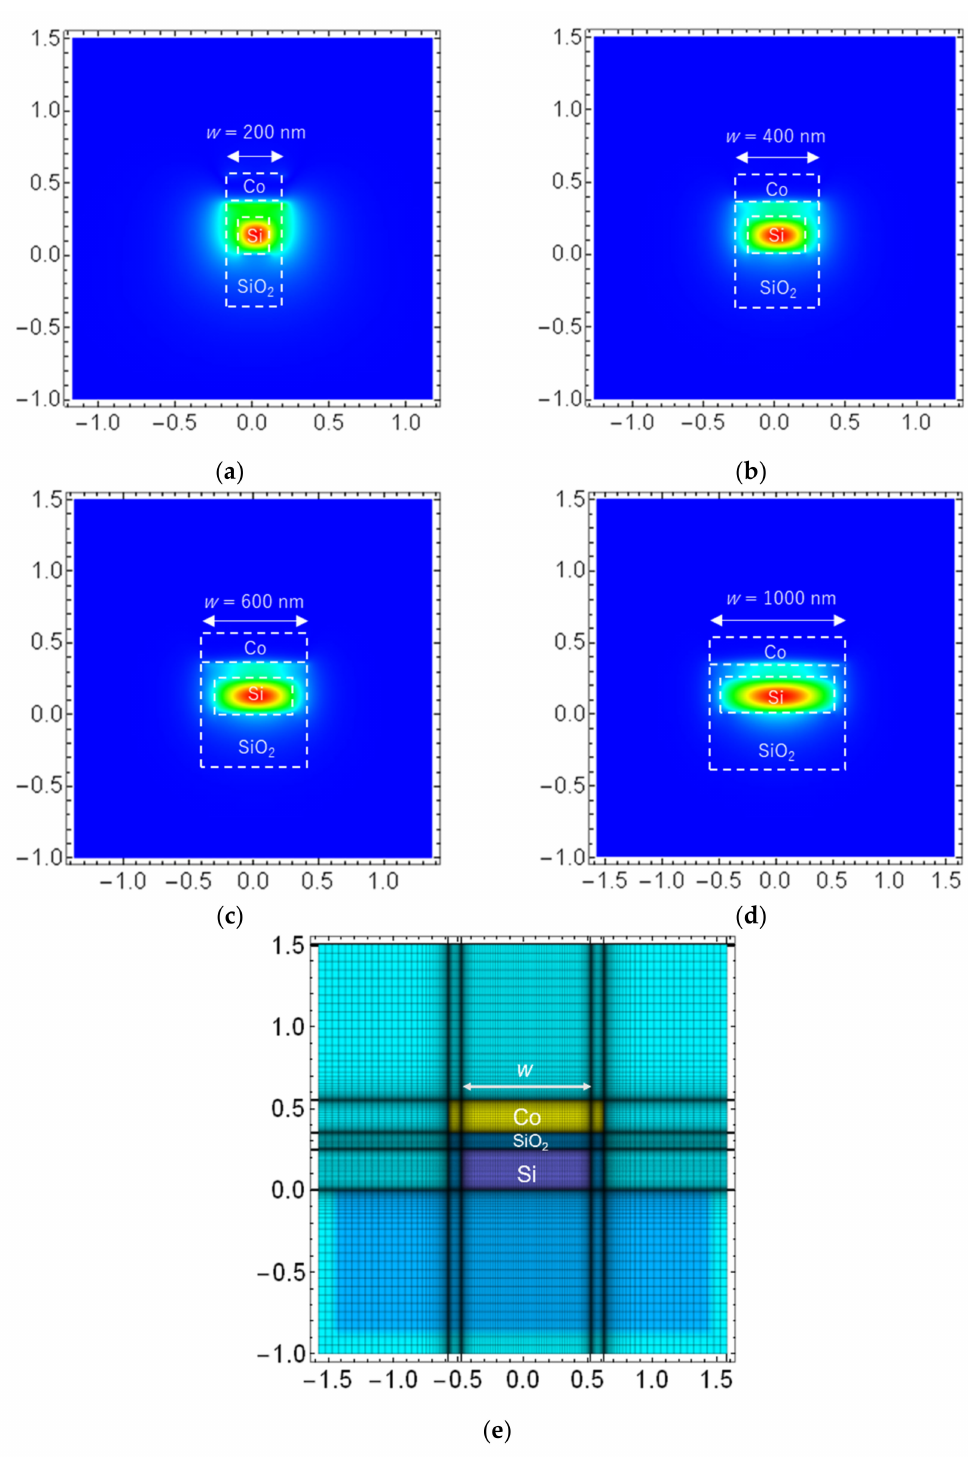
(cid:12) (cid:12) Figure 8. Calculated profile of the horizontal component of the magnetic field (absolute value (cid:12) ) for TM-like mode light (cid:12) H y with the Si waveguides for waveguide width ( a ) w = 200 nm, ( b ) 400 nm, ( c ) 600 nm, and ( d ) 1000 nm. ( e ) Definition of the mesh for calculation of the mode profile. The interfaces between the Co, SiO 2 , and Si layers are shown by white dotted lines. Estimated temperature rise of 331 K with ∆ R max = 0.048 Ω for w = 400 nm was determined with sampling time interval (1 s) of the digital multimeter used in this study, so that smaller temperature rise is expected to be measured with a higher time